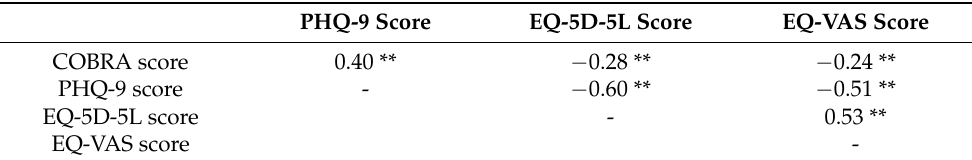
Table 2. Associations between cognitive complaints, depressive symptoms, HRQoL, and perceived overall health ( n = 525).